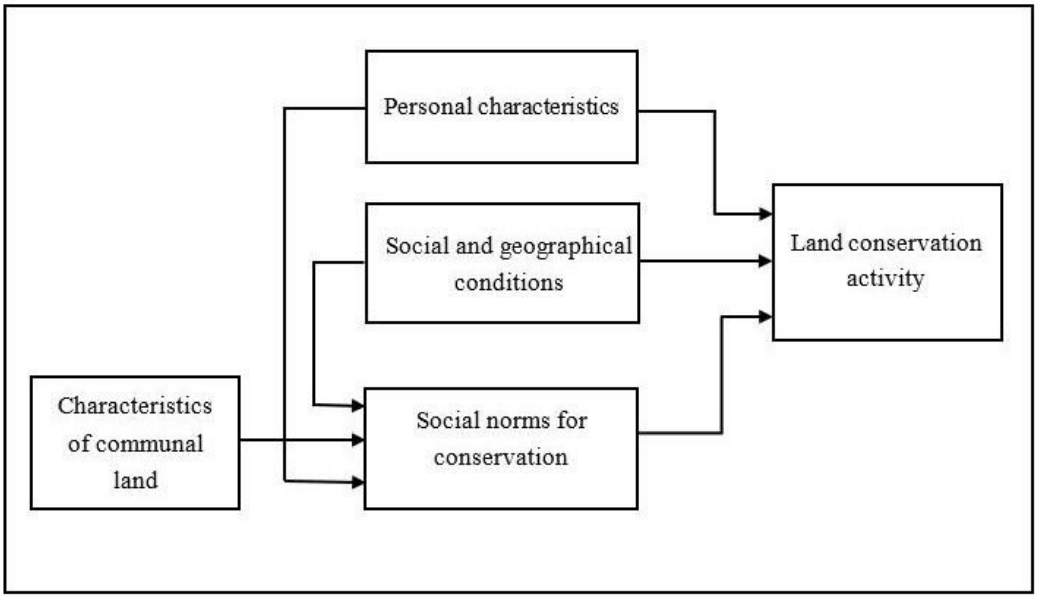
Figure 1. Conceptual framework for factors of conservation activity.